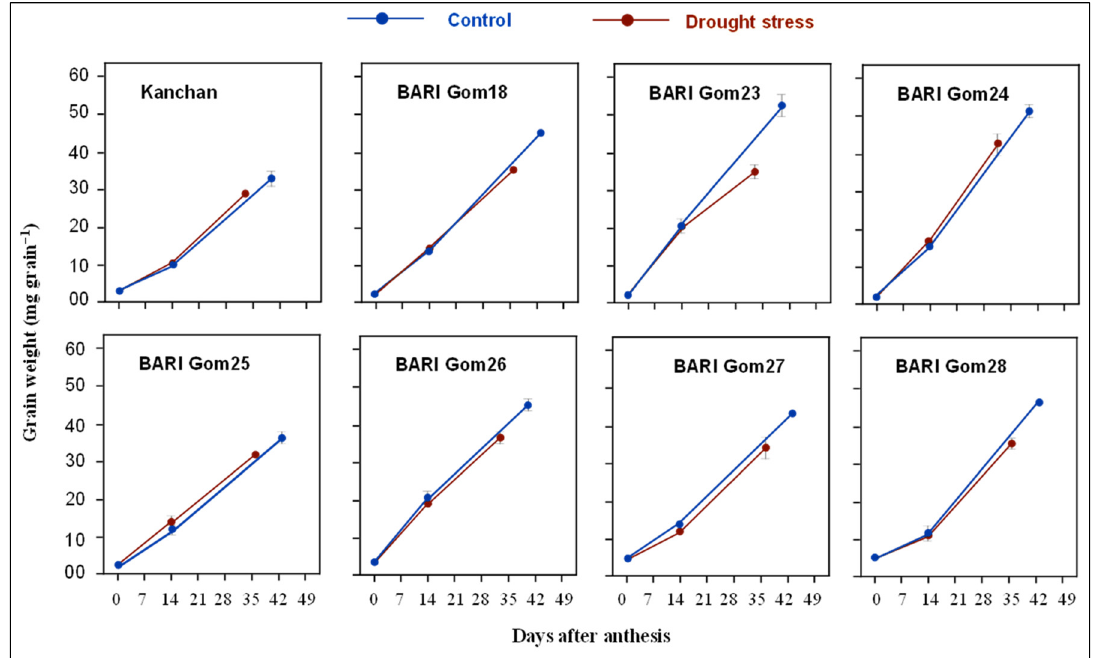
Figure 3. Changes in grain dry weight (g) of eight wheat cultivars as affected by drought stress during the grain-filling period. Vertical bars represent standard errors of means ( n = 3).